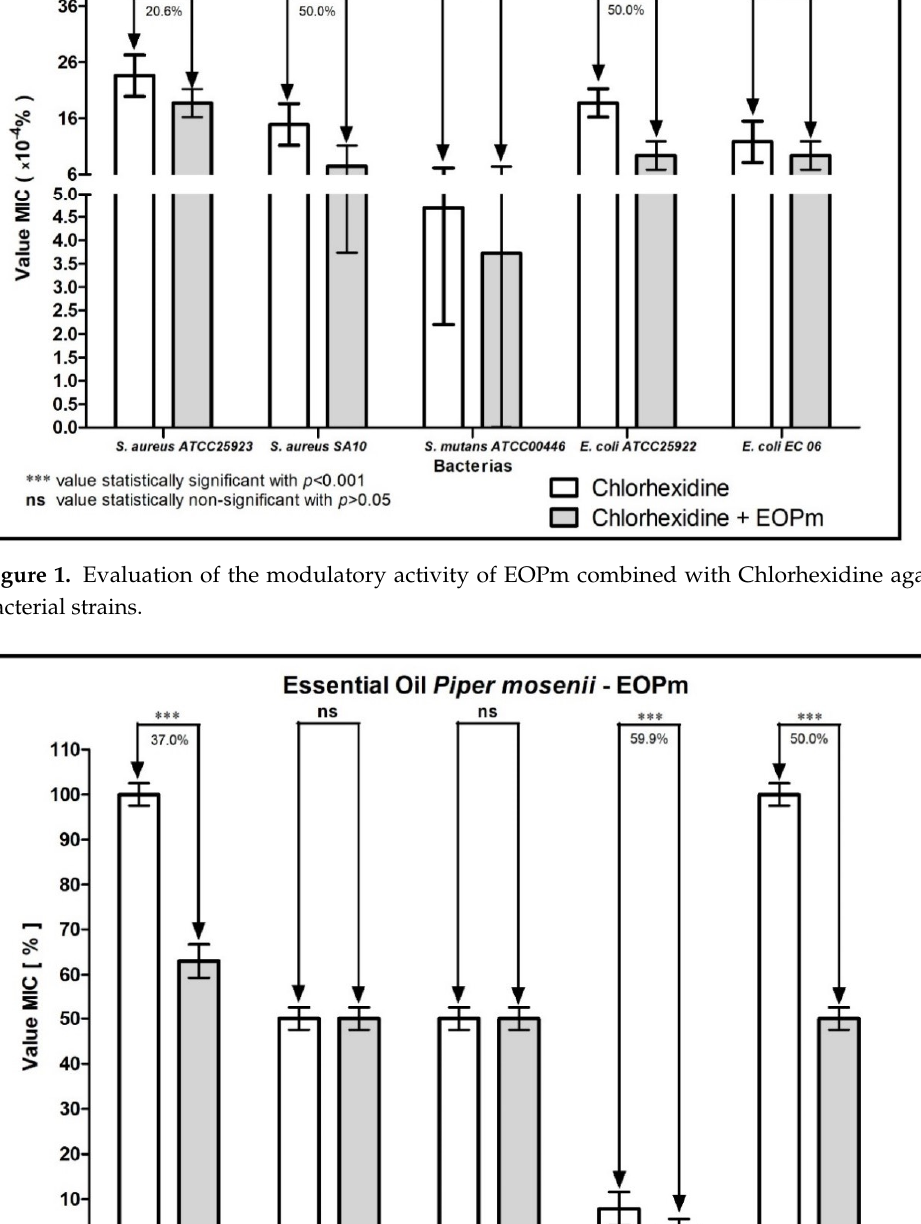
Figure 3. Evaluation of the modulatory activity of EOPm combined with Ampicillin against bacte- rial strains.